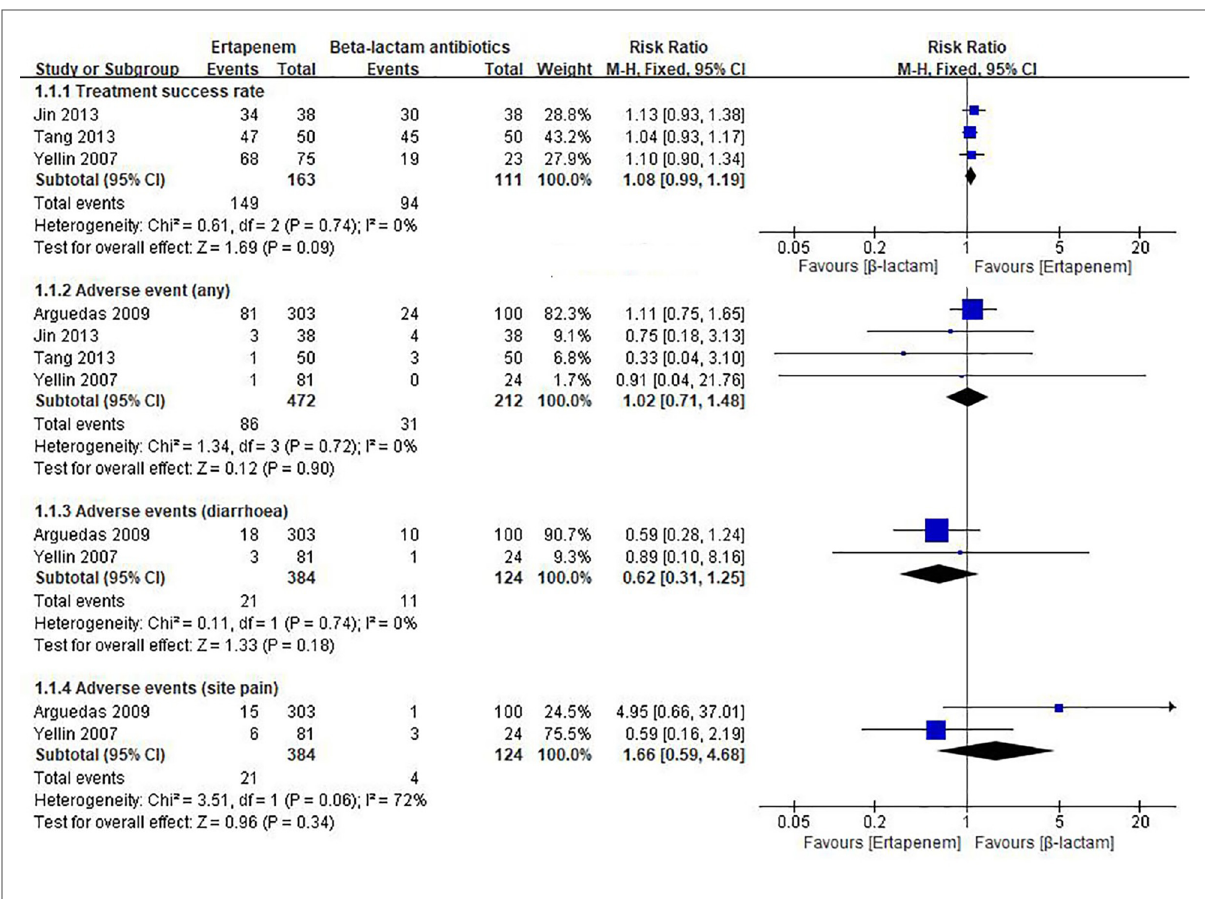
FIGURE 3 Meta-analysis for ertapenem vs. β -lactam antibiotics in